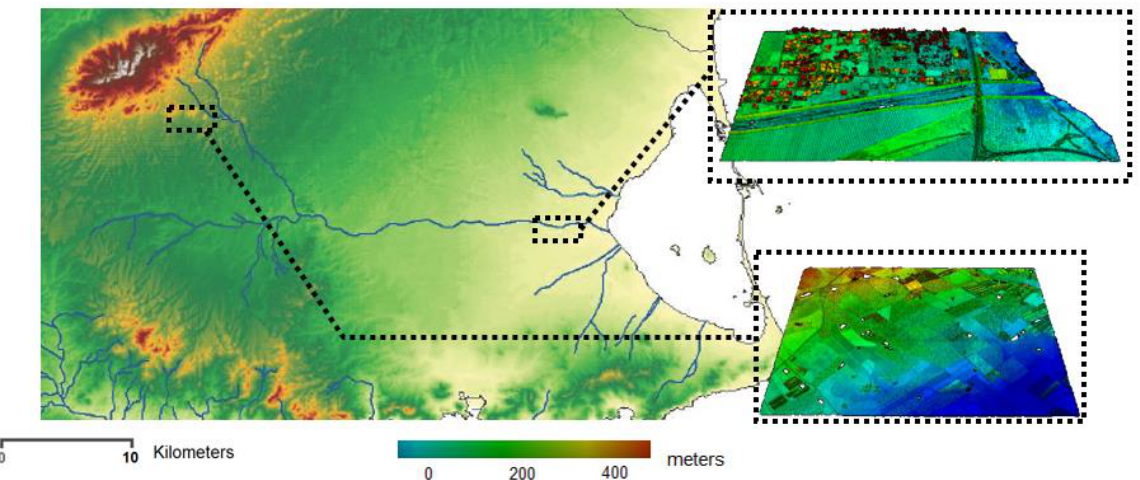
Figure 8. Digital Elevation Model of Campo de Cartagena area: comparison of wadis’ (blue lines) origin and finish. Source of the data: LiDAR SDI tools from IMIDA Institute of the Region of Murcia [32].